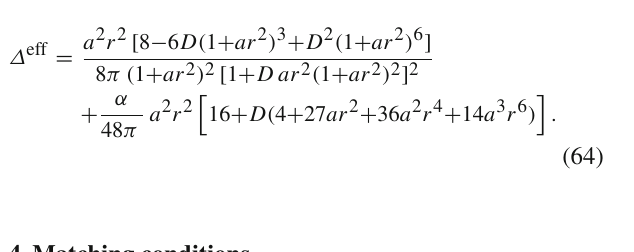
Using Eqs. (62) and (63), we obtain effective anisotropy Δ eff